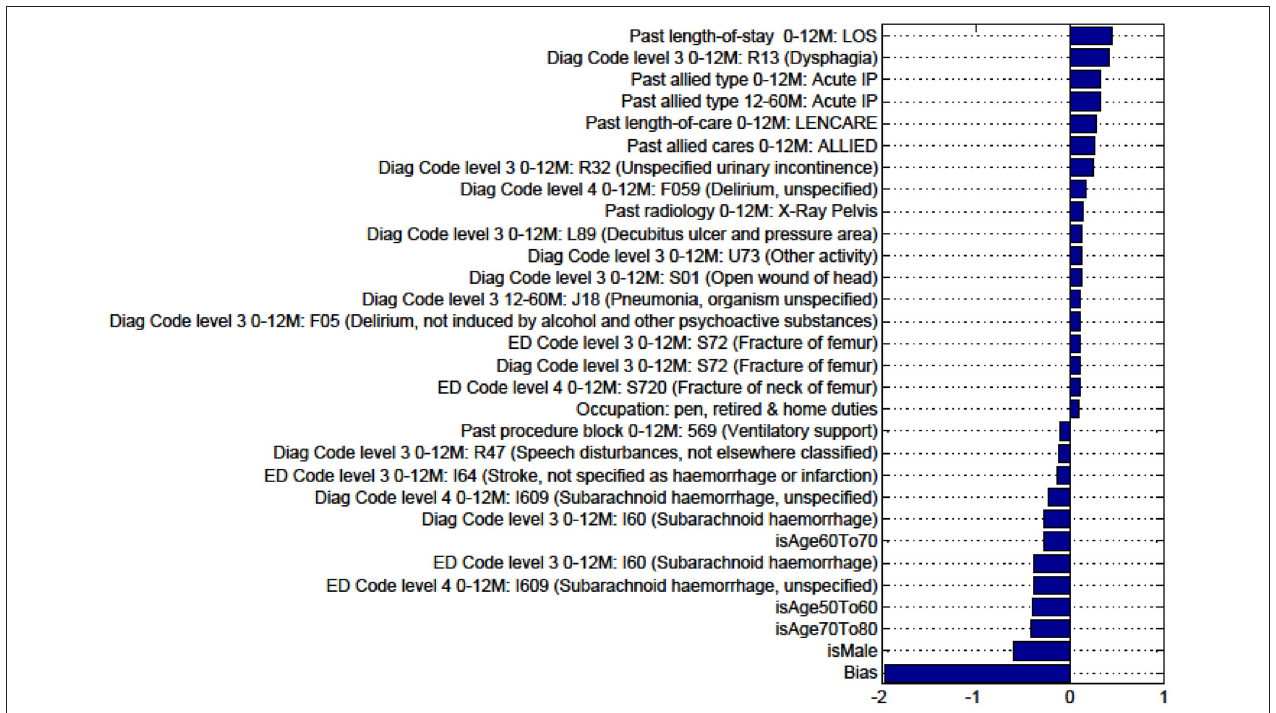
FIGURE A3 | Factors for prediction of Discharge to Nursing Home vs Rehabilitation for the sub-cohort of intracerebral hemorrhage stroke patients.